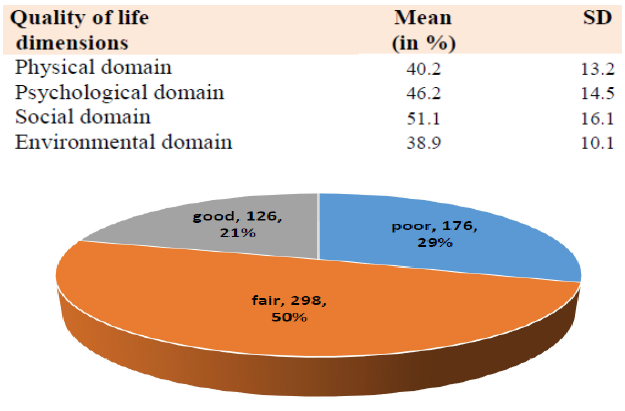
Table (2) Distribution of studied subjects according to mean quality of life domains.